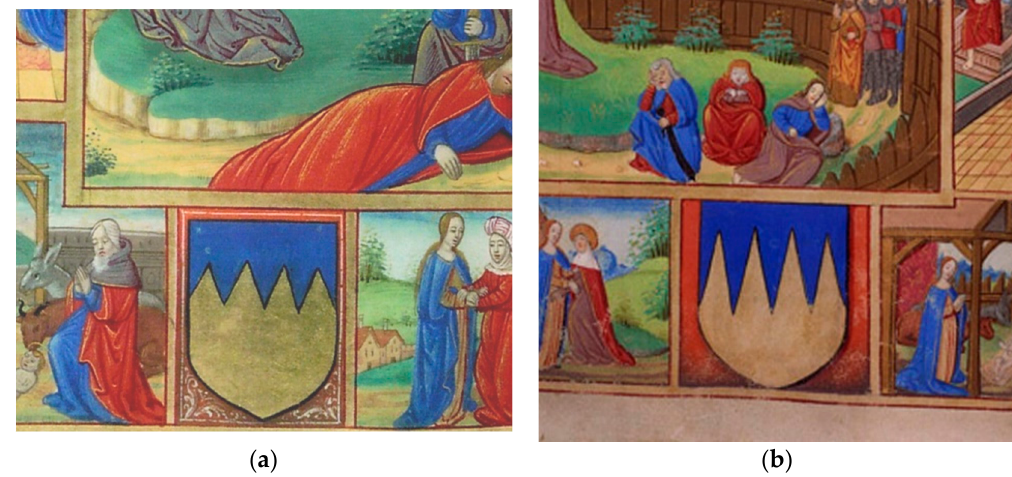
Figure 1. ( a ) Butler arms, The Hours of the Earls of Ormond, London, British Library Harley MS 2887, f.28v, ( b ) Butler arms, The Hours of Thomas Butler, London, British Library Royal MS 2 B XV, f.15v, © British Library Board.